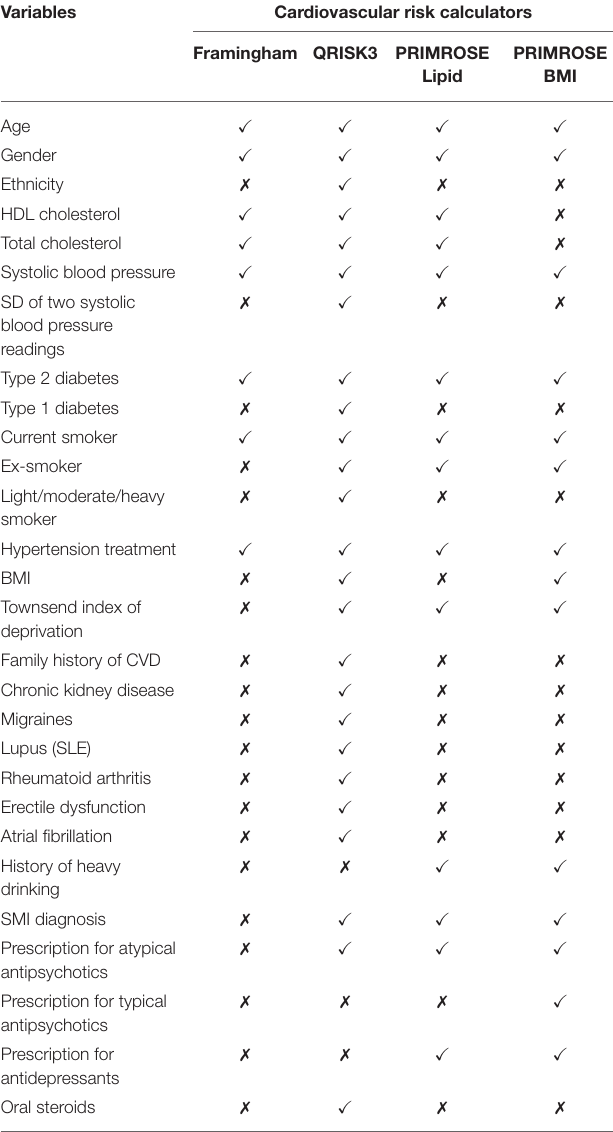
TABLE 1 | Comparison of risk factors included in four cardiovascular risk